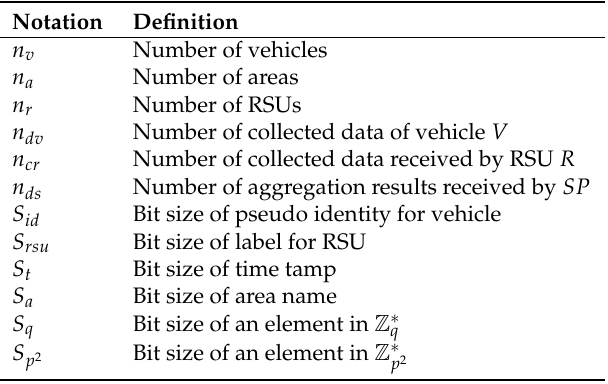
Table 7. Notations for storage and communication cost